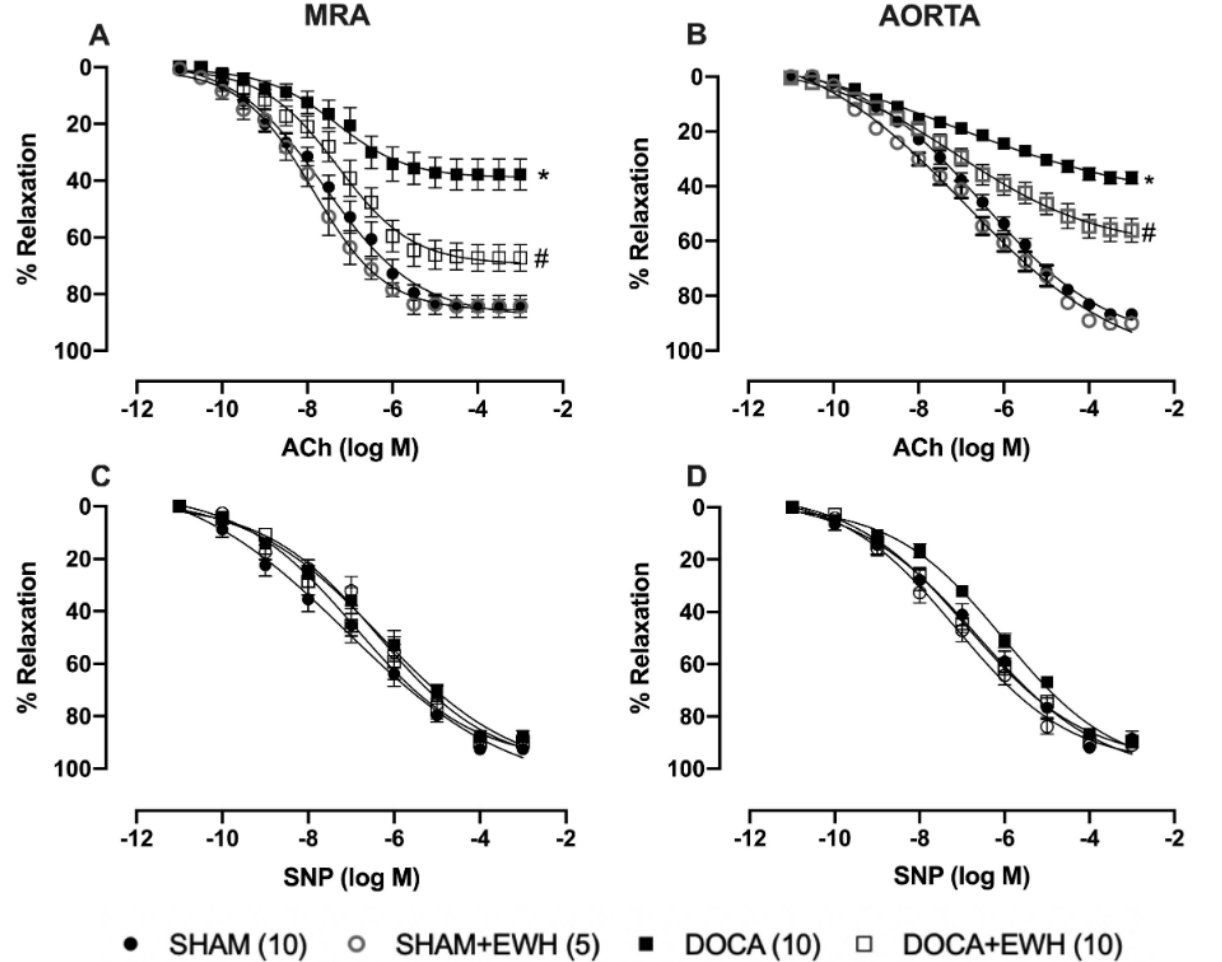
Figure 3. Effect of EWH in endothelium-dependent and -independent relaxation of MRA and aorta segments from DOCA-salt rats. Concentration–response curves to ACh ( A , B ) and SNP ( C , D ) in MRA and aorta segments from SHAM, SHAM+EWH, DOCA, and DOCA+EWH groups. The results are expressed (mean ± SEM) as the percentage of relaxation responses in norepinephrine or phenylephrine precontracted rings. The number of rats is indicated in parentheses. Two-way ANOVA followed by Bonferroni post-test: p < 0.05 * vs. SHAM; # vs. DOCA. To corroborate these findings, in situ vascular ROS detection was evaluated. In